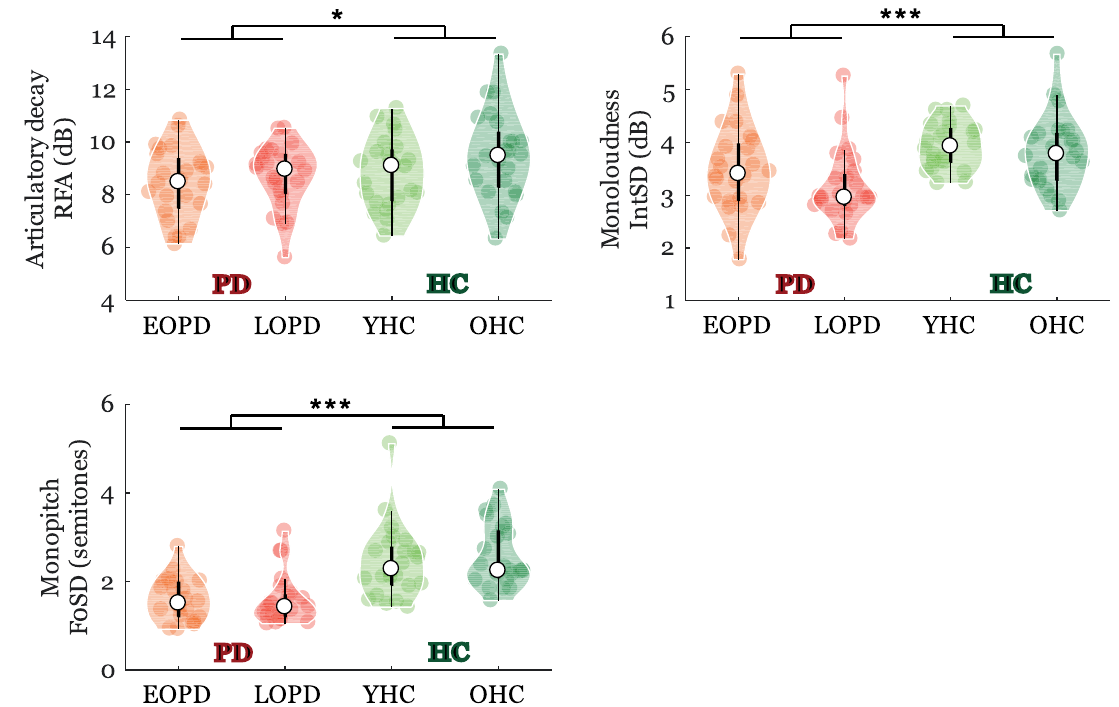
Fig. 2 Violin plots of parkinsonian-speci fi c speech characteristics. The plot shows the median (indicated by the black open circle), the interquartile range (the thick, solid vertical band), estimator of the density (color vertical curves) of the individual scores in each group (comparable to a box plot, except that the distribution of values is illustrated as density curves), and individual scores (color fi lled circles). Statistically signi fi cant differences for GROUP effect: * p < 0.05; ** p < 0.01, *** p < 0.001. HC = healthy controls, PD = Parkinson ’ s disease; EOPD = early-onset Parkinson ’ s disease; LOPD = late-onset Parkinson ’ s disease; YHC = young healthy controls; OHC = old healthy controls; RFA = resonant frequency attenuation; IntSD = intensity variability; F0SD = fundamental frequency